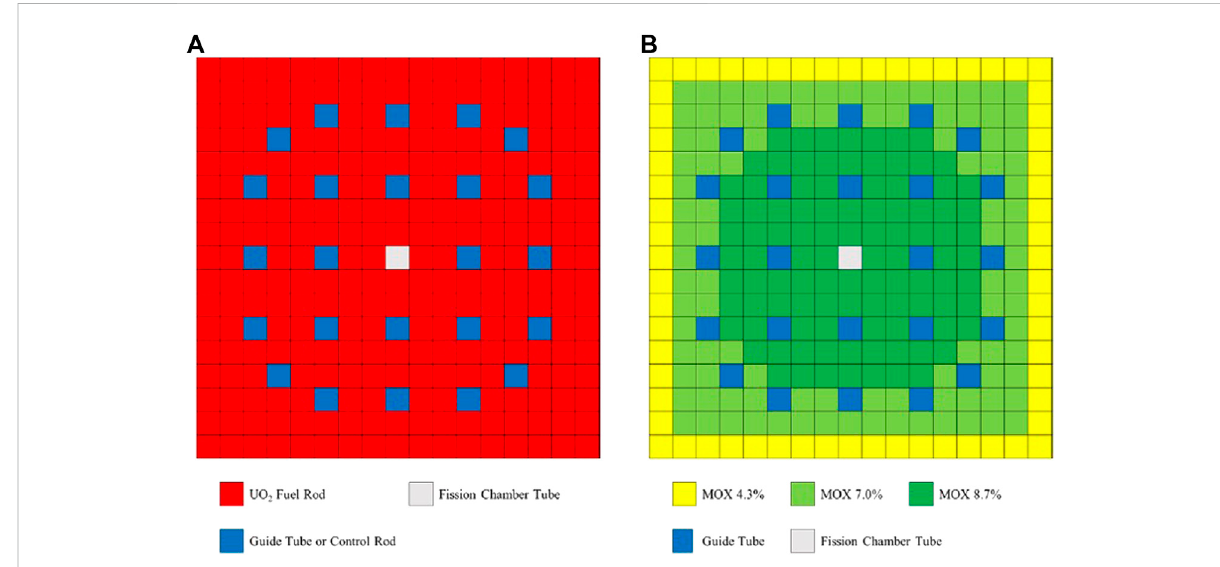
FIGURE 9 Fuel assembly con fi guration of the full-core MOX/UOX pin-by-pin models: (A) UOX fuel assembly and (B) MOX fuel